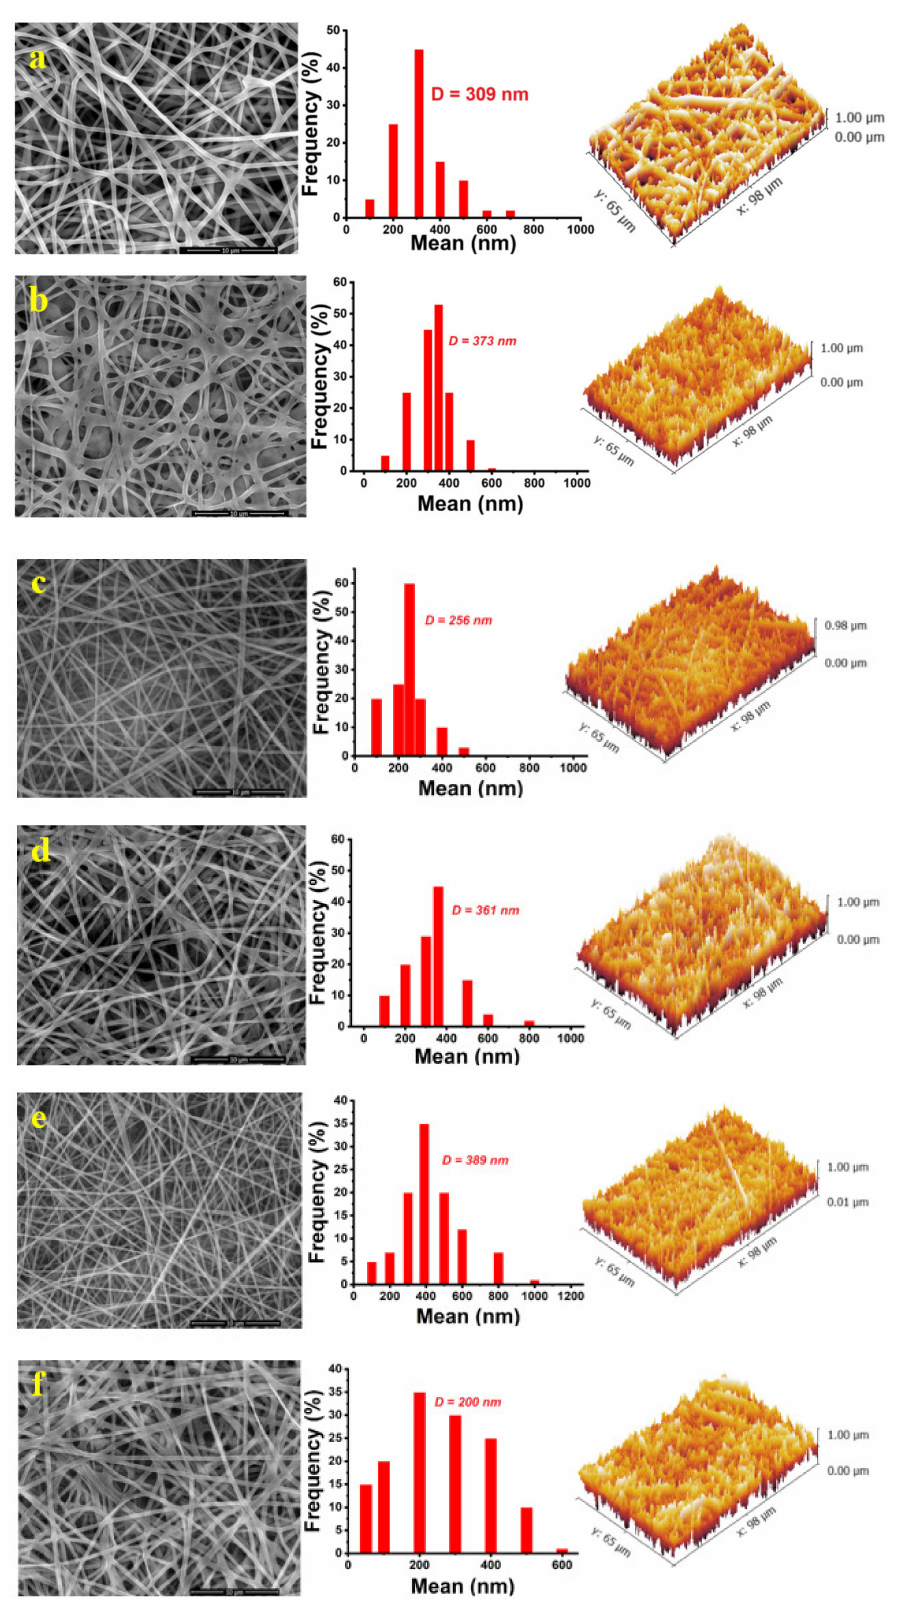
Figure 1. SEM, dynamic light scattering (DLS), and surface roughness of nanoformulated fiber webs: ( a ) pure PVA (NF1), ( b ) PVA / Mox (NF2), ( c ) PVA / Cs(Rg) (NF3), ( d ) PVA / Cs(Rg) / Mox (NF4), ( e ) PVA / Cs(Rg) / β -CD (NF5), and ( f ) PVA / Cs(Rg) / β -CD / Mox